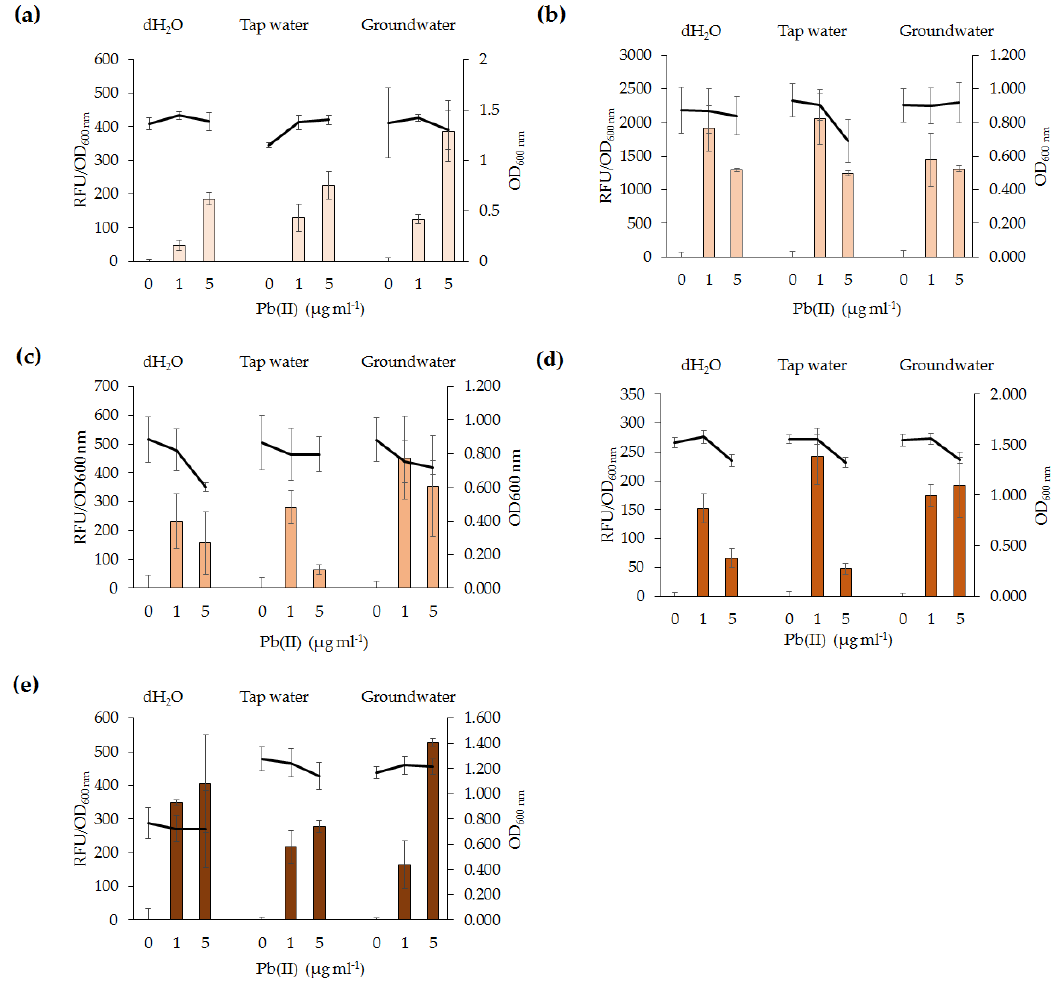
Figure 6. The lead biosensors were exposed to varying concentrations (0, 1, and 5 µg·mL −1 ) of Pb(II) in the following environmental samples; sterile dH 2 O, unsterilized tap water